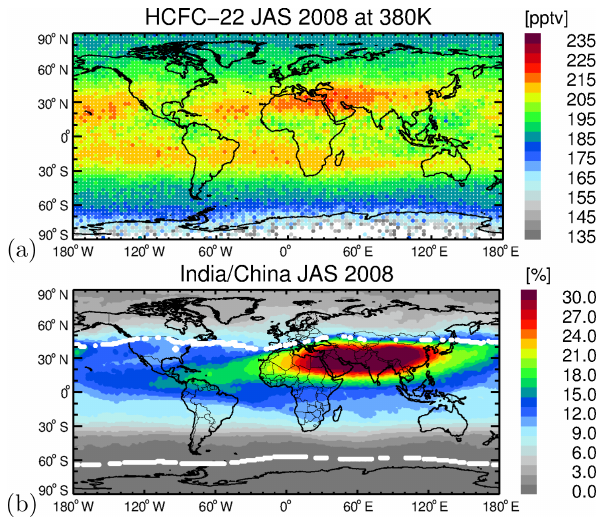
Figure 13. Mean values of HCFC-22 (a) measured by MIPAS for July, August, and September 2008 at 380K synoptically interpo- lated using CLaMS trajectory calculations (for more details, see Sect. 4.4.1). Panel (b) is similar to Fig. 12d, but for the year 2008.